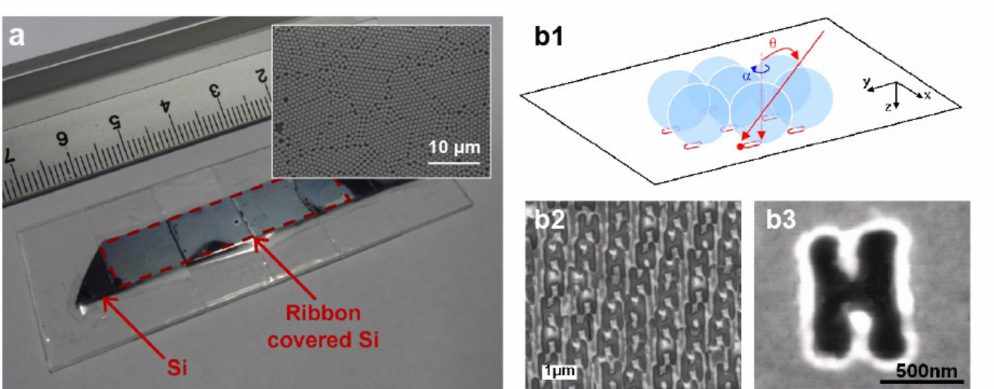
Figure 5. Parallelization of photonic nanojets. ( a ) Polypropylene substrate coated with acrylic adhesive for transporting microsphere array (referred to as the ‘Ribbon’) onto a Si surface. The inset shows a scanning electron micrograph of the array. Adapted with permission from [85] Copyright 2011 Elsevier. ( b1 ) Schematic diagram of nanojet lithography under oblique illumination. ( b2 , b3 ) Scanning electron micrograph of H-shape arrays produced with tilted nanojets. Reprinted with permission from [88] Copyright 2009 Institute of